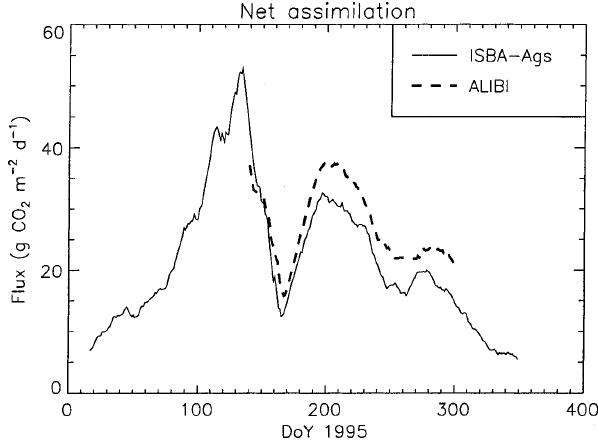
Fig. 12. The daily net CO assimilation as modelled by ISBA-Ags 2 (Calvet et al., 1998b) and ALiBi in 1995. The annual cycle is smoothed using a 30-day moving average in order to show the general